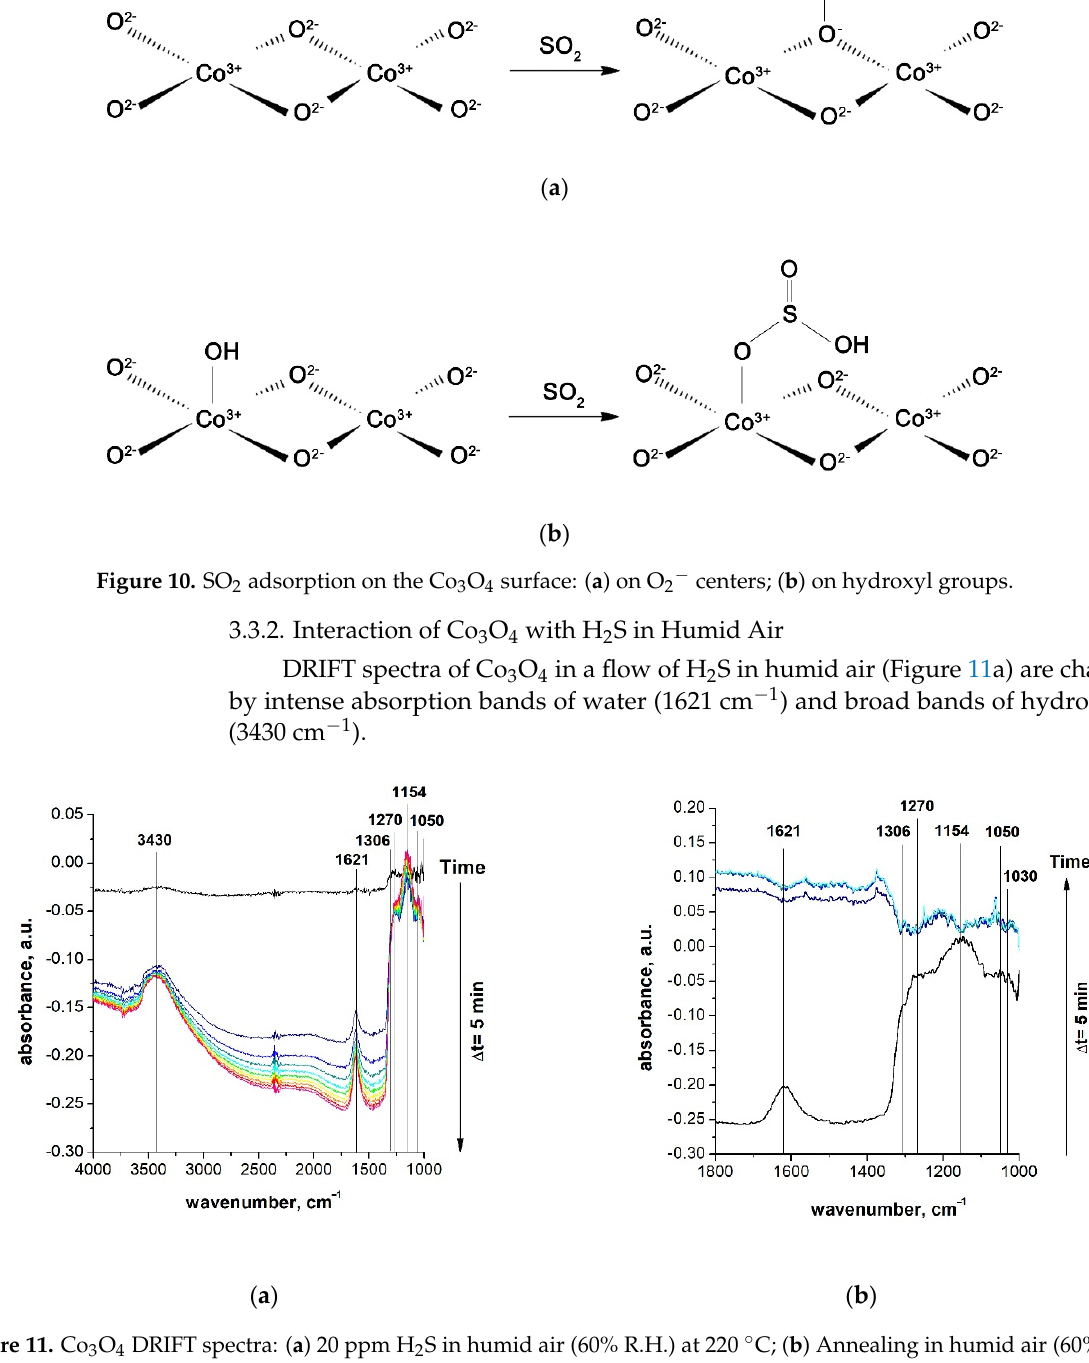
Figure 12. Decomposition of sulfites on Co 3 O 4 in the presence of water.